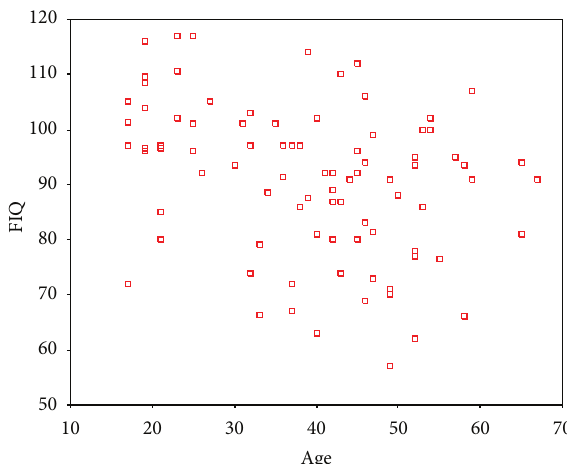
Figure 5: Partial correlation analysis showed a negative relation between age and IQ. Correlation coefficient was − 0.287 ( 𝑃 = .008 ).